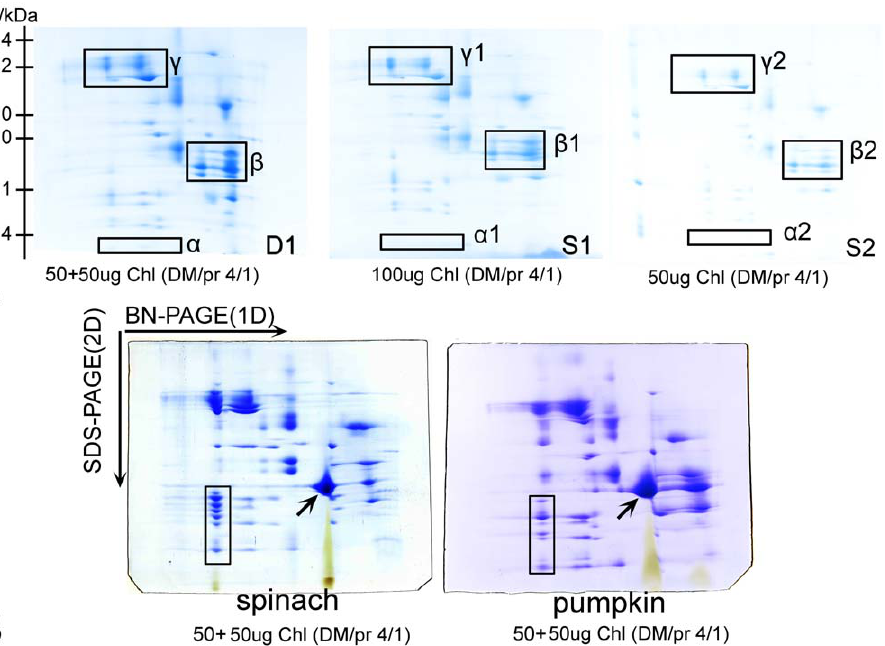
Figure 3. Resolution comparison between ‘‘single-strip BN/SDS-PAGE’’ and "double-strips BN/SDS-PAGE’’ with membrane proteins. A : Comparison of 2D gels pattern between ‘‘Single-strip BN/SDS-PAGE’’ and ‘‘Double-strips BN/SDS-PAGE’’ in rice. ( D1 ): The pattern of ‘‘Double-Strips BN/SDS-PAGE’’ with two 1D BN-Gel lane strips each loaded with 50 m g chlorophyll dissolved at DDM/protein ratio of 4/1. ( S1 ): The pattern of ‘‘Single-Strip BN/SDS-PAGE’’ with one 1D BN-Gel strip loaded with 100 m g chlorophyll dissolved at DDM/protein ratio of 4/1. ( S2 ): The pattern of ‘‘Single-Strip BN/SDS-PAGE’’ with one 1D BN-Gel strip loaded with 50 m g chlorophyll dissolved at DDM/protein ratio of 4/1. (Parts of regions a , b and c in the panels of 2D SDS-gels represent the obvious difference between these methods). B : The pattern of the thylakoid membrane proteins from Spinacia oleracea and Cucurita spp. separated by ‘‘Double-Strips BN/SDS-PAGE’’. The amounts of chlorophyll and detergent/protein ratios were labelled in the panels.